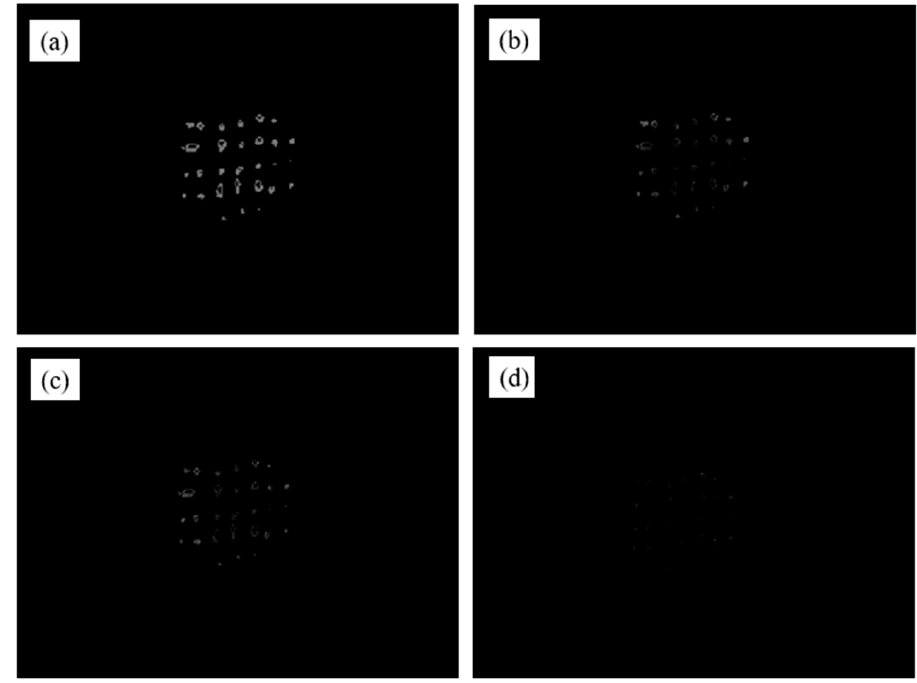
Figure 4. The images of eigenvalues. ( a ) λ 1 ; ( b ) λ 2 ; ( c ) λ 3 ; ( d ) λ 4 .